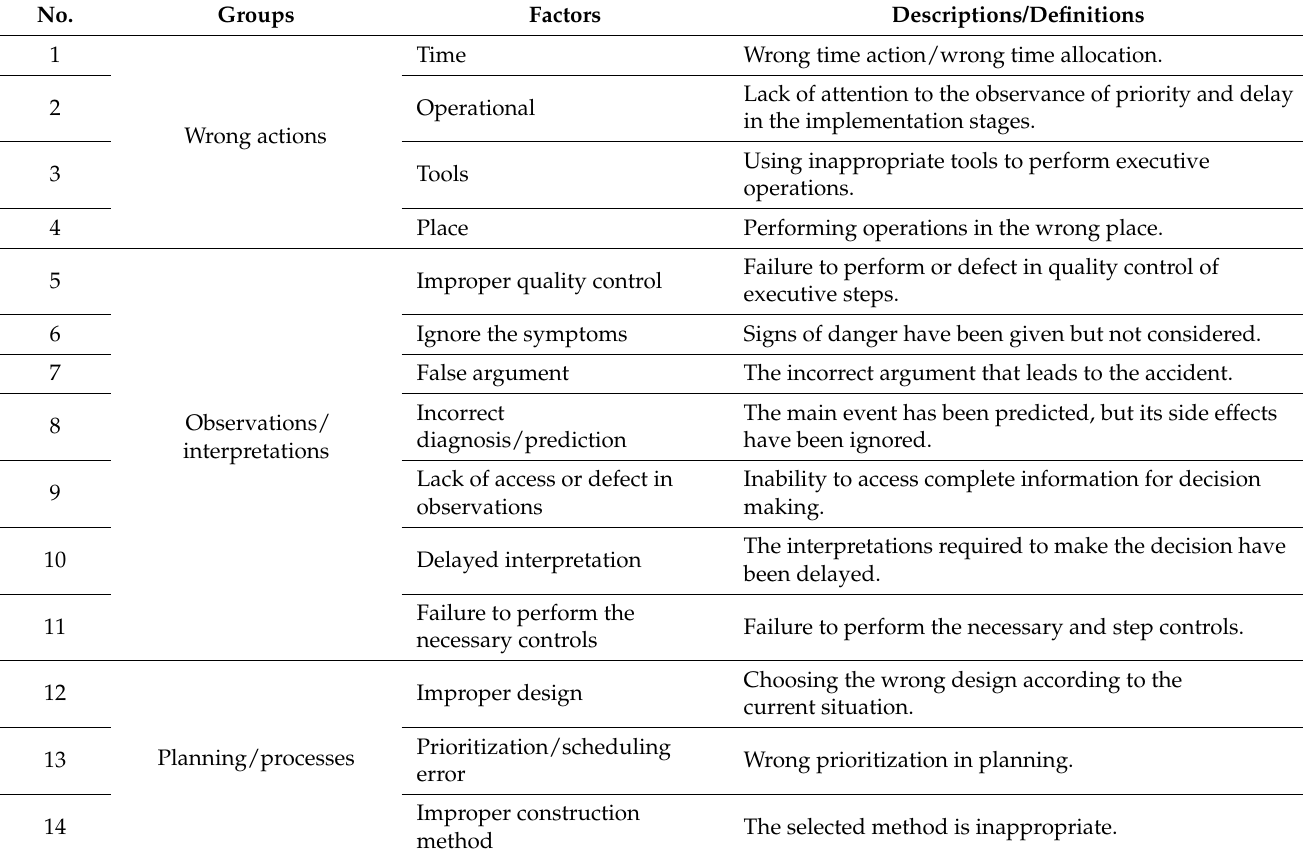
Table 2. Results of the fourth phase of the fuzzy Delphi survey for the key factors affecting the occurrence of construction accidents in industrial parks construction